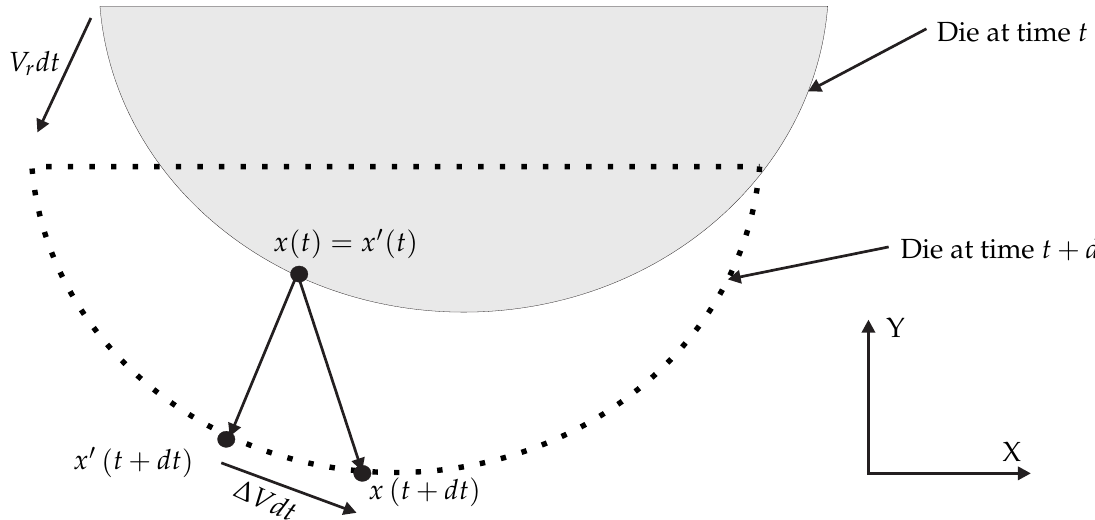
Figure 2. The slab point and rolling die surface have same position at the time t but at the increment of time t + dt they have different position due to the velocity difference.